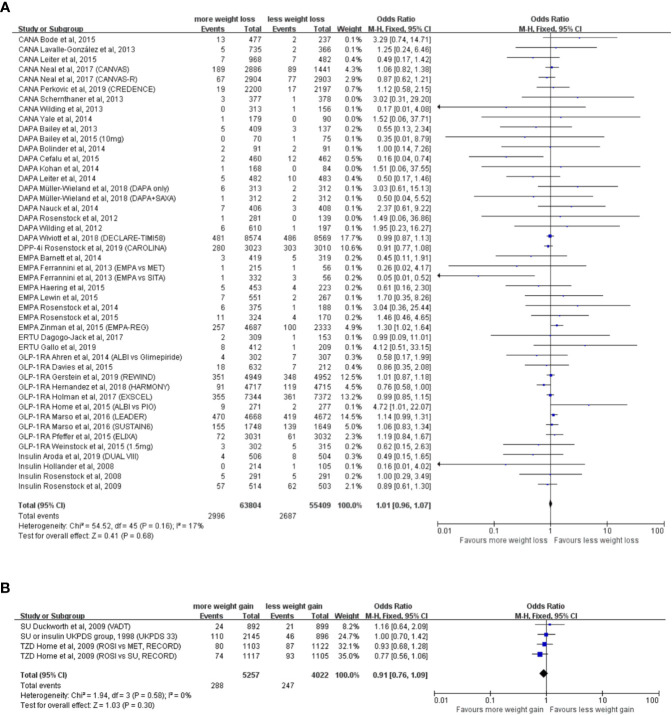
Weight alteration and incidence of neoplasm in randomized clinical trials of patients with type 2 diabetes. (A) Randomized controlled trials with weight reduction difference. CANA, canagliflozin; DAPA, dapagliflozin; EMPA, empagliflozin; ERTU, ertugliflozin; SAXA, saxagliptin; SITA, sitagliptin; GLP-1RA, glucagon-like peptide-1 receptor agonist; ALBI, albiglutide; DPP-4i, dipeptidyl-peptidase-4 inhibitors; MET, metformin; PIO, pioglitazone; PBO, placebo; CANVAS, Canagliflozin and Cardiovascular and Renal Events in Type 2 Diabetes; CANVAS-R, CANVAS-Renal; CREDENCE, Canagliflozin and Renal Outcomes in Type 2 Diabetes and Nephropathy; DECLARE-TIMI 58, The Dapagliflozin Effect on Cardiovascular Events-Thrombolysis in Myocardial Infarction; CAROLINA, Cardiovascular Outcome Study of Linagliptin versus Glimepiride in Patients with Type 2 Diabetes; EMPA-REG, Empagliflozin, Cardiovascular Outcomes, and Mortality in Type 2 Diabetes; HARMONY, Albiglutide and Cardiovascular Outcomes in Patients with Type 2 Diabetes and Cardiovascular Disease; REWIND, Dulaglutide and Cardiovascular Outcomes in Type 2 Diabetes; LEADER: Liraglutide and Cardiovascular Outcomes in Type 2 Diabetes; SUSTAIN6, Semaglutide and Cardiovascular Outcomes in Patients with Type 2 Diabetes; ELIXA, Lixisenatide in Patients with Type 2 Diabetes and Acute Coronary Syndrome; DUAL VIII, Durability of insulin degludec plus liraglutide versus insulin glargine U100 as initial injectable therapy in type 2 diabetes. (B) Randomized controlled trials with weight elevation difference. SU, sulfonylurea; TZD, thiazolidinedione; VADT, Veterans Affairs Diabetes Trial; ACCORD, The Action to Control Cardiovascular Risk in Diabetes; UKPDS, The UK Prospective Diabetes Study; RECORD, Rosiglitazone evaluated for cardiovascular outcomes in oral agent combination therapy for type 2 diabetes.